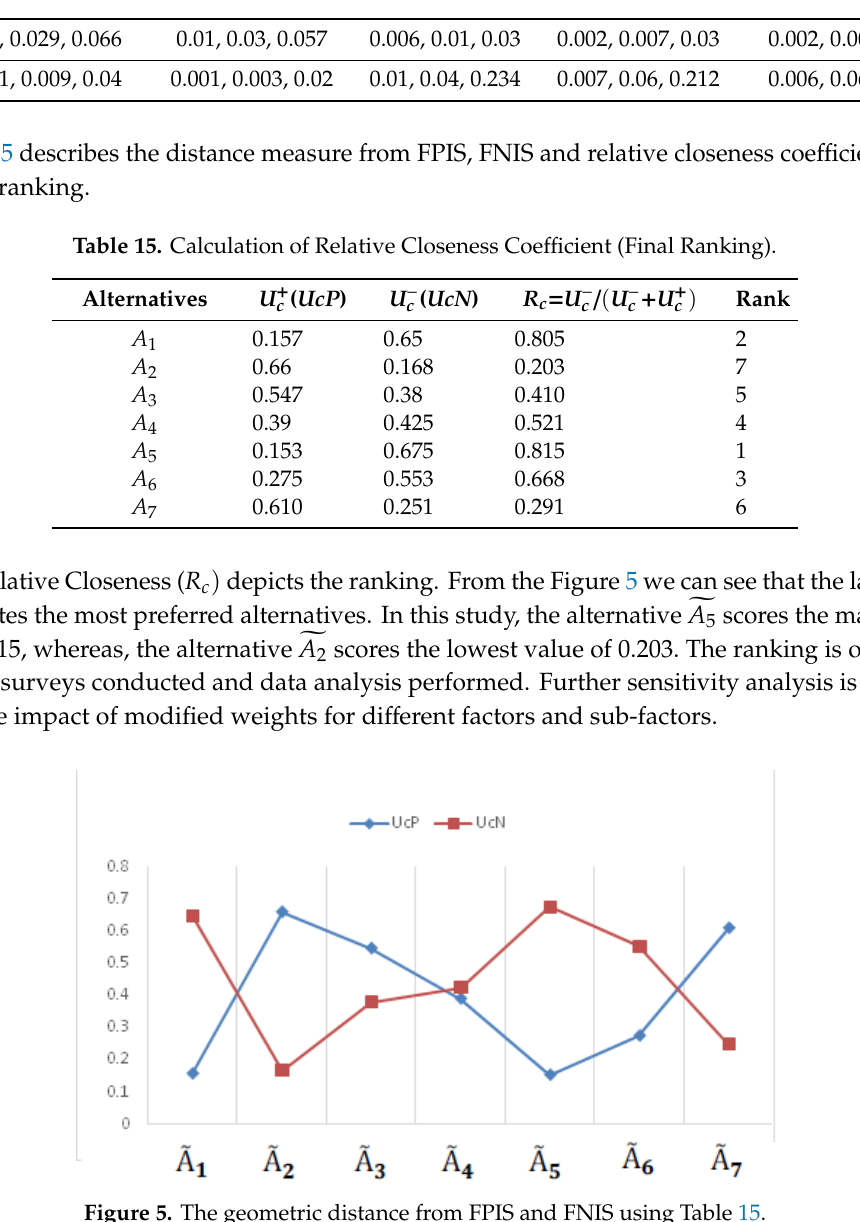
Table 14. Third part of FPIS and FNIS.